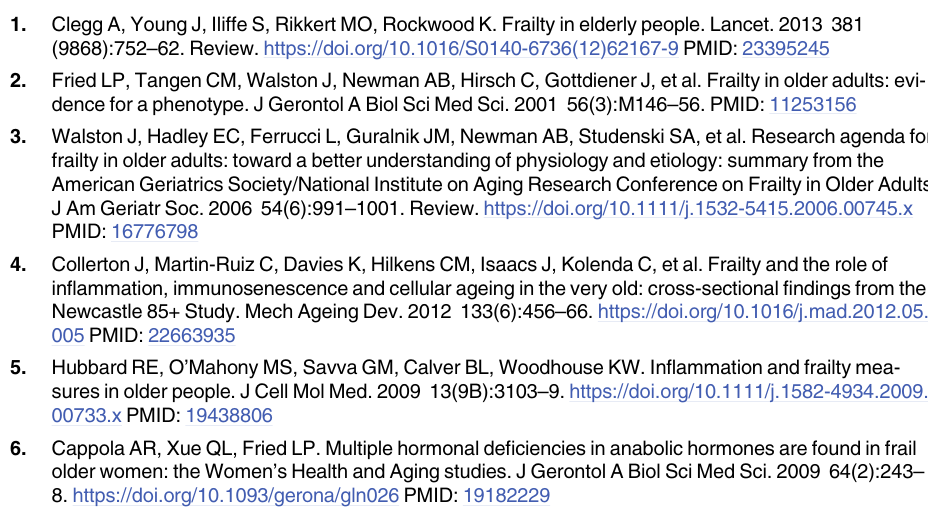
S1 Table. Phenotypes. Lists of deficits for the Frailty Index. S2 Table. Graphs. Distribution of the phenotypic variable. S3 Table. GenAssoc. The most significant results of the genome-wide association scan. S4 Table. Plots. QQ and Manhattan plots of the